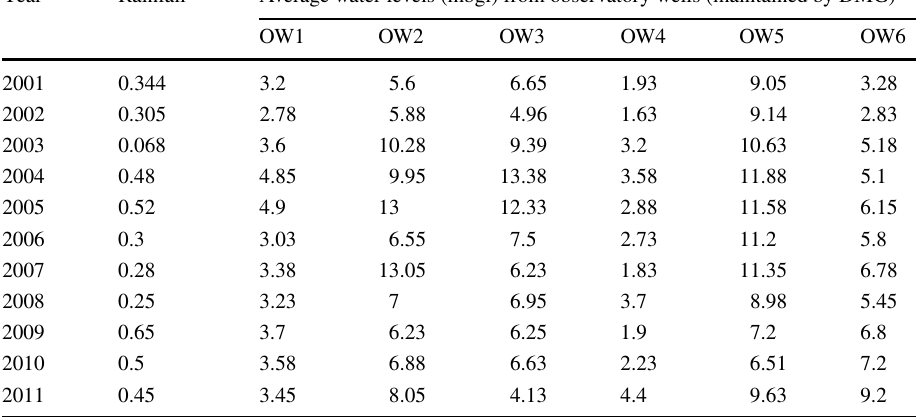
Table 4 Winter rainfall and water-table